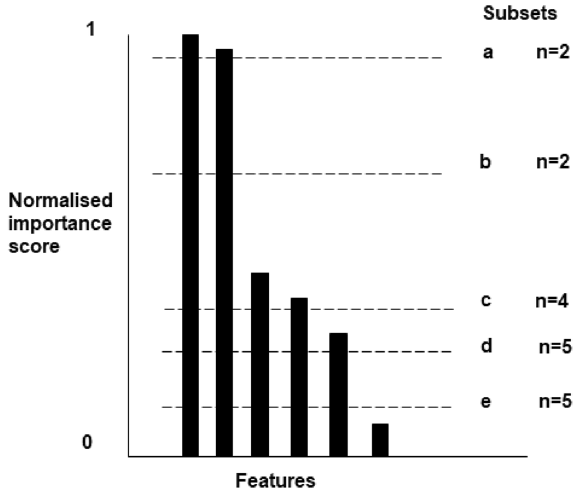
Figure 9. Schematic representation of the normalised importance score plot for the selected predictor feature set. Subsets of features were selected based on arbitrary threshold normalised importance values. Steps 2 and 3 of the process flow were then applied to each of these